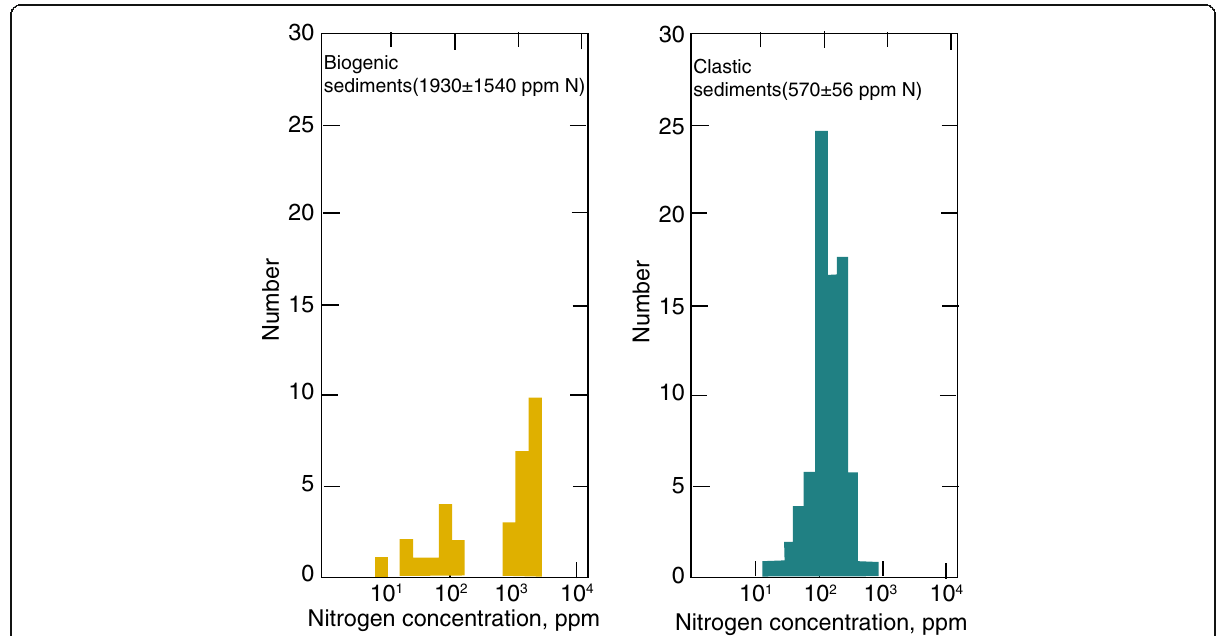
Fig. 3 Distribution of nitrogen concentrations in various continental sedimentary rocks modified after Johnson and Goldblatt (2015)